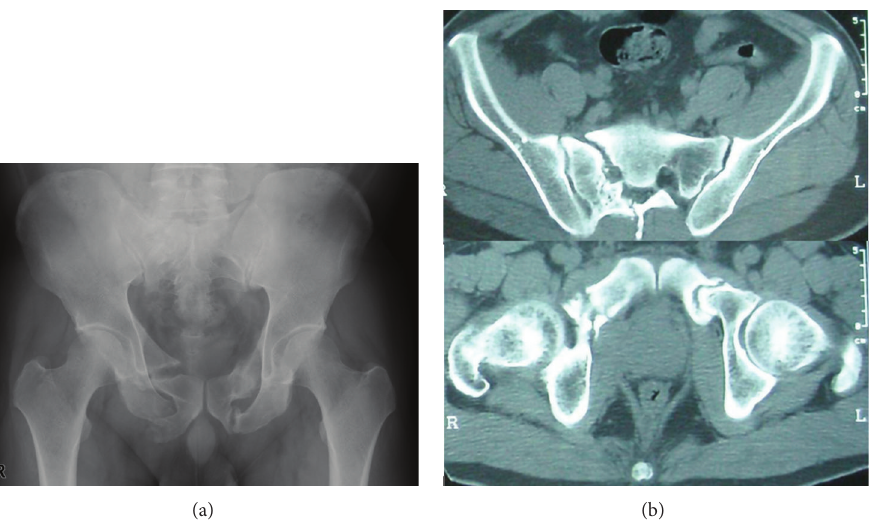
Figure 1: Anteroposterior radiograph (a) and CT images (b) of the pelvis at 5 months after injury, showing nonunion of the right sacrum bone and bilateral pubic rami.